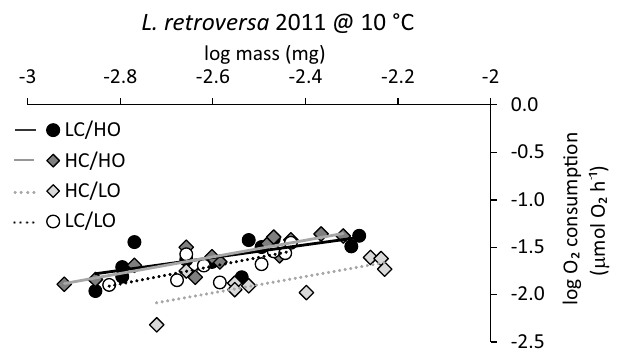
Figure 4. Log-transformed metabolic rates (µmolO 2 h − 1 ) for L. retroversa at 10 ◦ C, not normalized to mass, plotted against the log-transformed wet mass (mg) of individuals exposed to low CO 2 and normal O 2 (black circles; LC/HO), high CO 2 and normal O 2 (dark grey diamonds; HC/HO), low CO 2 and low O 2 (white circles; LC/LO), or high CO 2 and low O 2 (light grey diamonds;